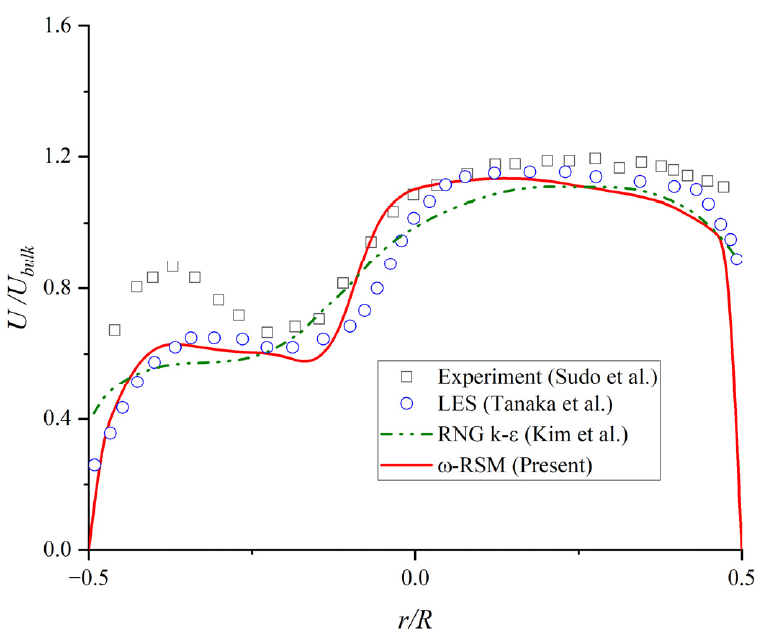
Figure 4. Velocity profiles at the outlet of elbow for validation study at Reynolds number of 60,000.